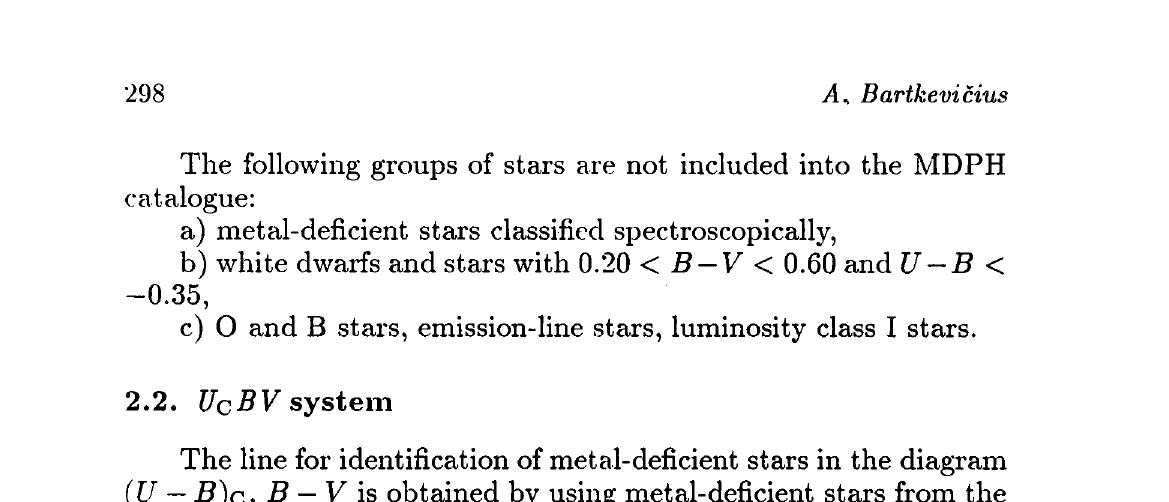
Table 4. The line for identification of metal-deficient stars in the